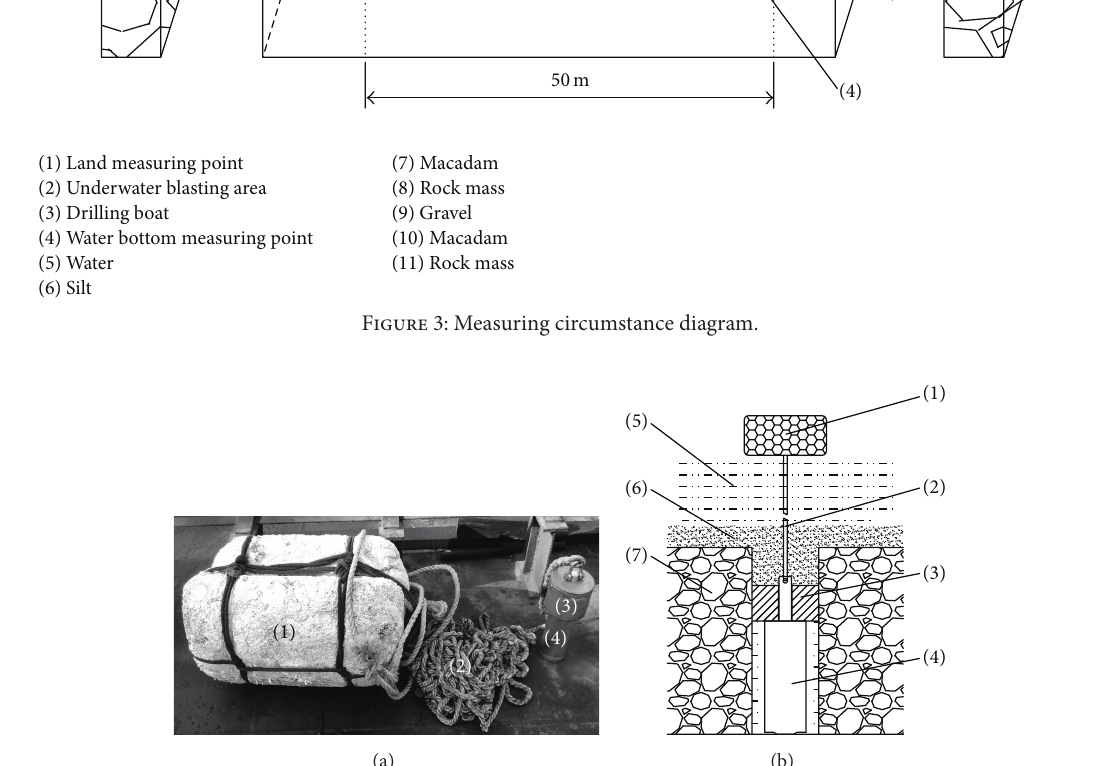
Figure 4: WBV setting diagram. (1) Float, (2) rope, (3) positioning block, (4) WBV, (5) water, (6) silt, and (7) base rock.